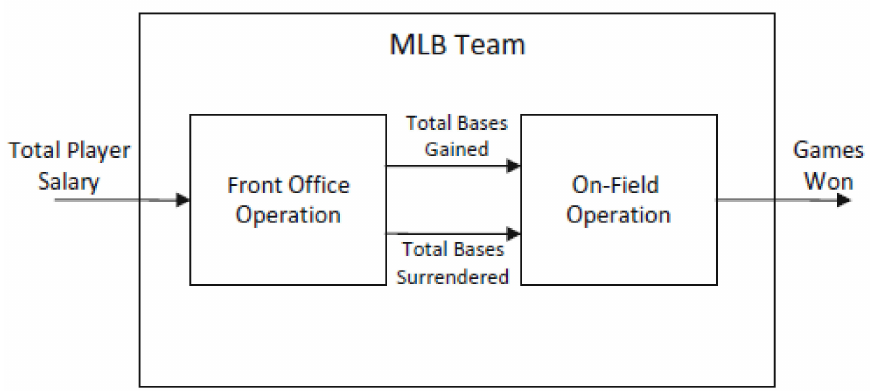
Figure 2. The unoriented two-stage DEA methodology of MLB team management e ffi ciency [11]. Reproduced with permission from Lewis, H.F et al., Eur. J. Oper. Res. ; published by Elsevier, 2013.